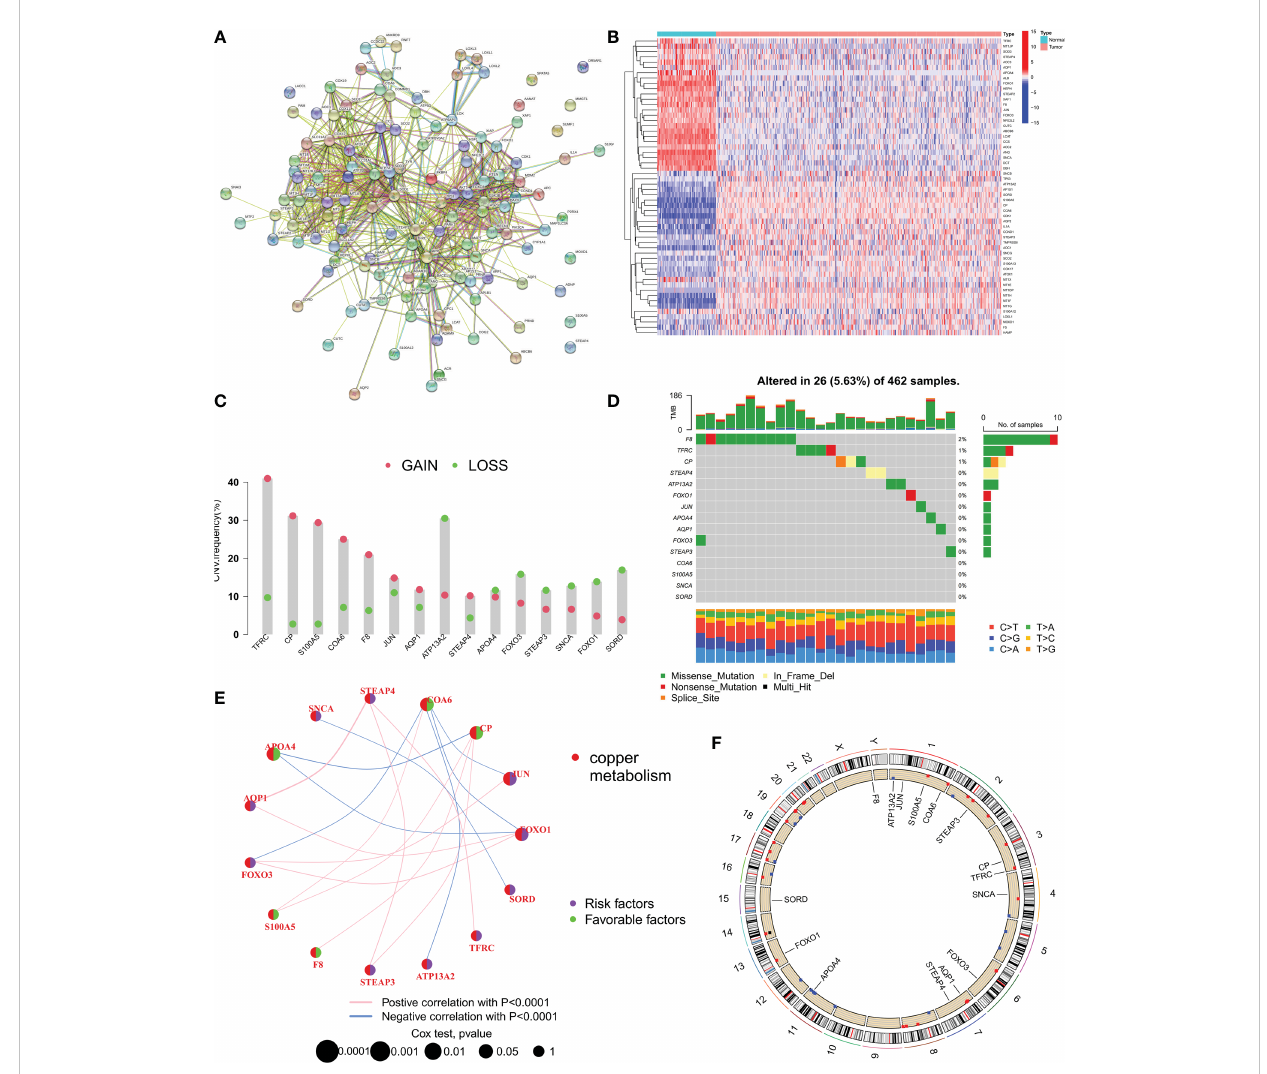
FIGURE 1 Expression and mutation of copper metabolism-related genes (CMRGs) in ovarian cancer. (A) Protein-protein interaction (PPI) network of all 133 copper metabolism-related genes (CMRGs). (B) Heat map of differential expression of CMRGs between tumor and normal tissues. (C) CNV frequencies of CMRGs in the TCGA cohort. (D) Mutation frequencies of 15 CMRGs in 462 OC patients in the TCGA cohort. (E) Network plot showing the correlation of 15 CMRGs in OC and the impact on prognosis. (F) The location of 15 CMRGs on 23 human